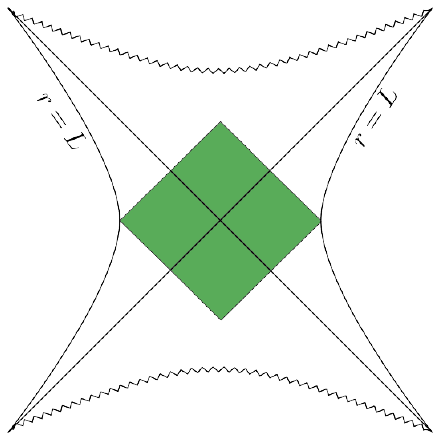
Figure 4 . If a box is too small ( L < L c ) the non-computing features can